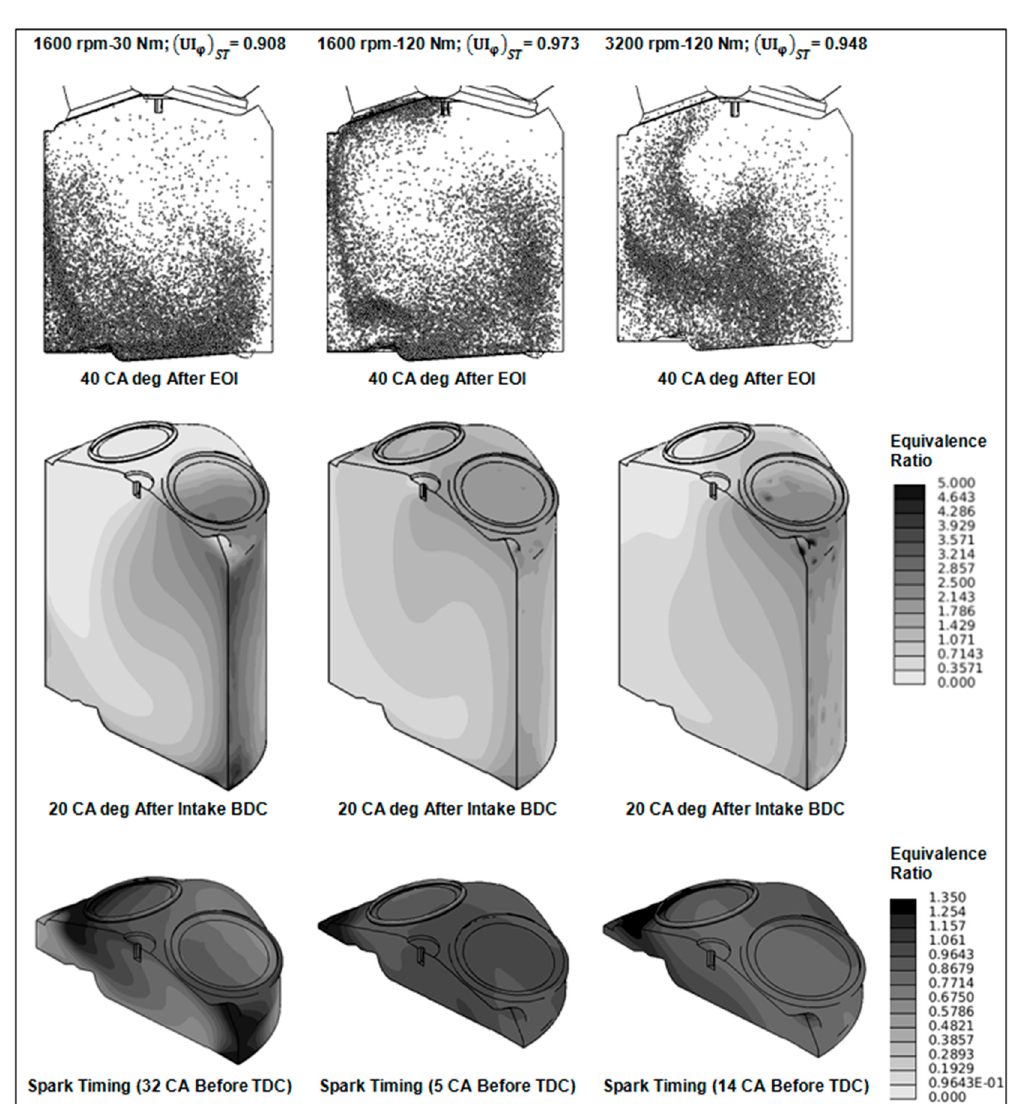
Figure 10. CFD images of the mixture preparation process (liquid droplet distribution and equivalence ratio distribution) at various CA locations for three representative engine running